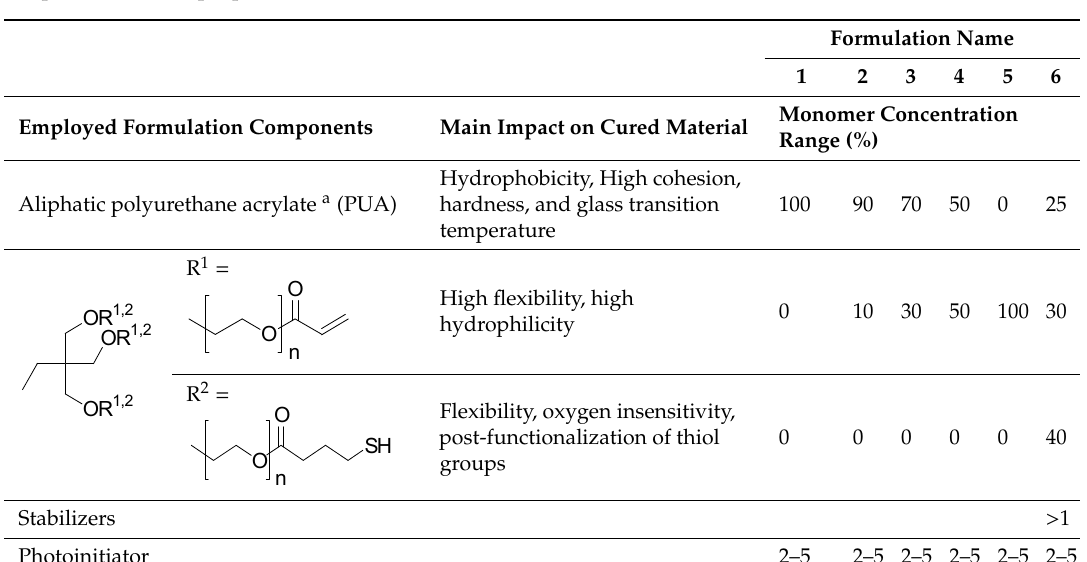
Table 1. Summary of the used monomers for prototyping a hydrophilic UV-curable formulation with post-functional properties.